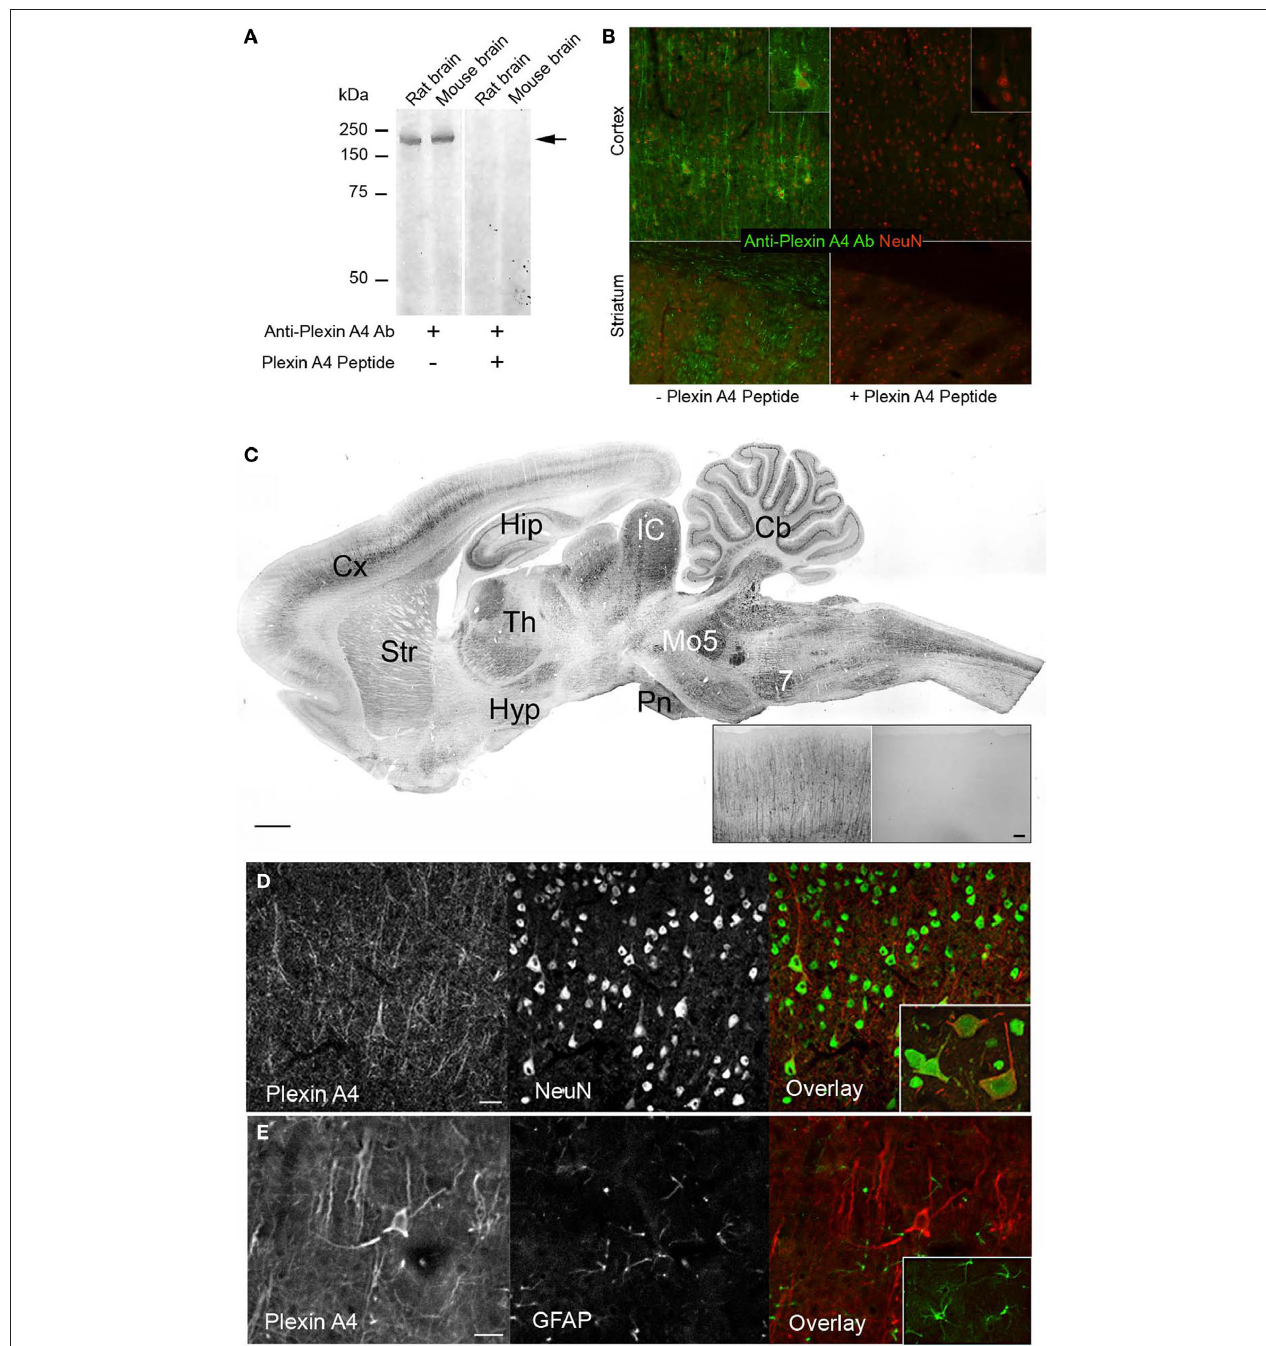
Figure 1 | Specificity of the polyclonal PlexinA4 antibodies. (A) Aliquots of rat and mouse brain tissue were subjected to SDS/7.5% PAGE and immunoblotted with polyclonal anti-PlexinA4 antibodies. Molecular mass standards (in kDa) are indicated on the left. A band of ∼ 210 kDa is detected in both rat and mouse tissue (arrow). (B) Representative coronal sections from PlexinA4 (green) and NeuN (red) co-immunostained rat cortex and striatum. PlexinA4 immunolabeling is abolished after preabsorption over excess PlexinA4 peptide. (C) Parasagittal section from an adult rat brain immunolabeled with PlexinA4 antibodies. PlexinA4 immunostaining is visible in many brain regions including Cx, Hip, Str, Cb, and brain stem nuclei. Insert shows coronal sections of Cx from an adult rat brain immunolabeled with either PlexinA4 (left) or no primary antibodies (right). No staining is visible in the no